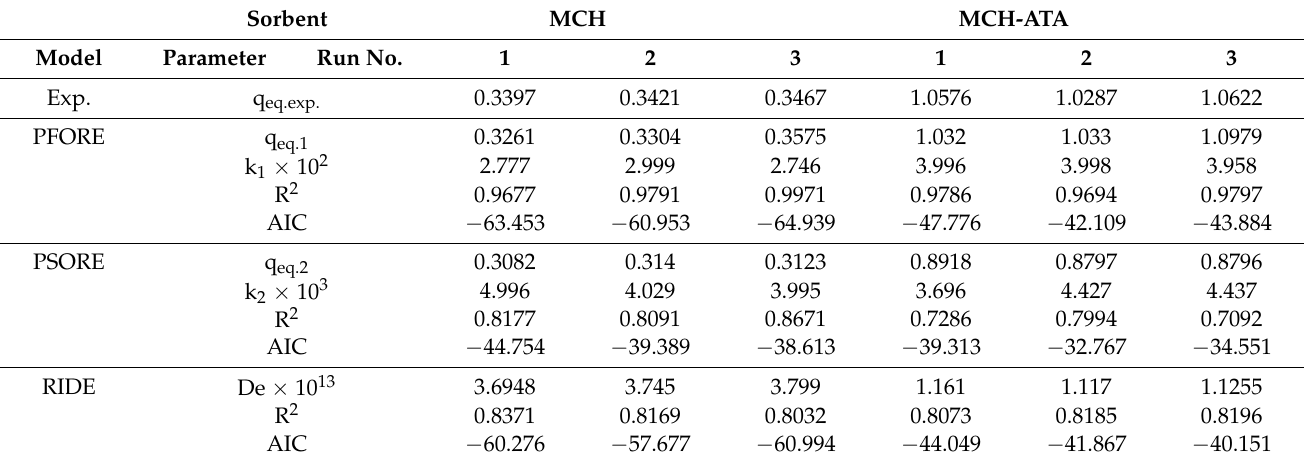
Table 2. Uptake kinetics modeling for Cd(II) removal using MCH and MCH-ATA